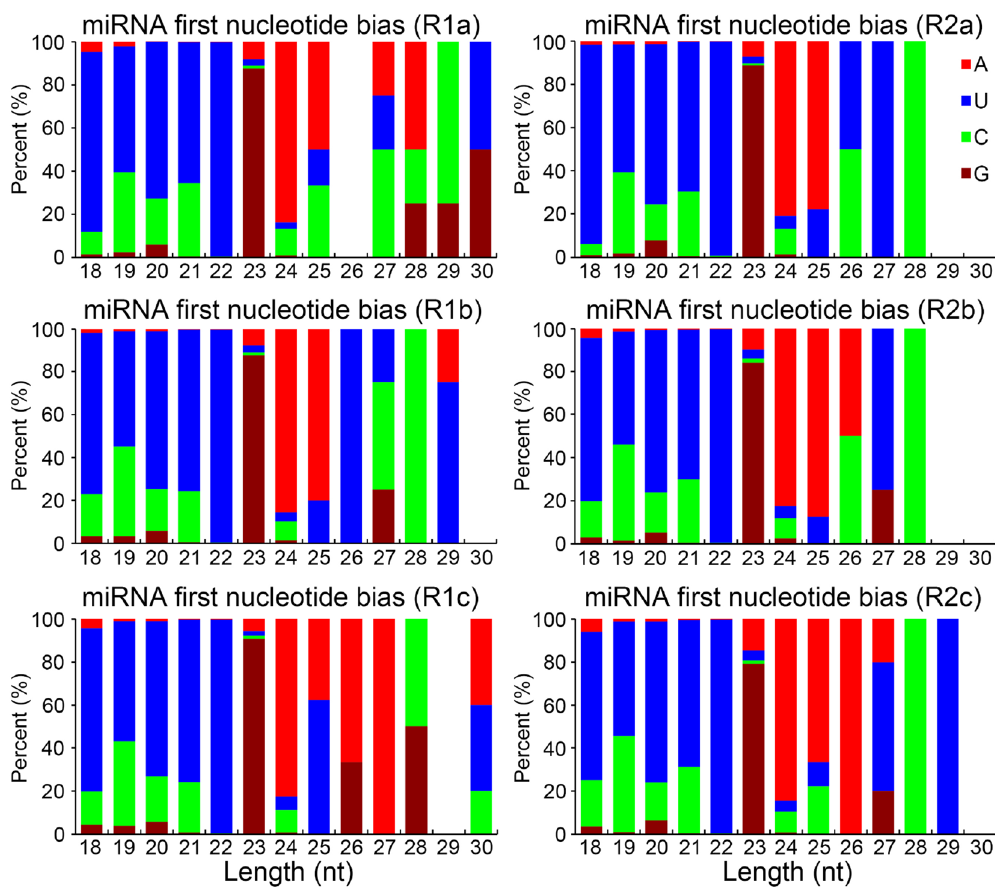
Figure 3. The preference to the first nucleotide of miRNAs according to the novel miRNA